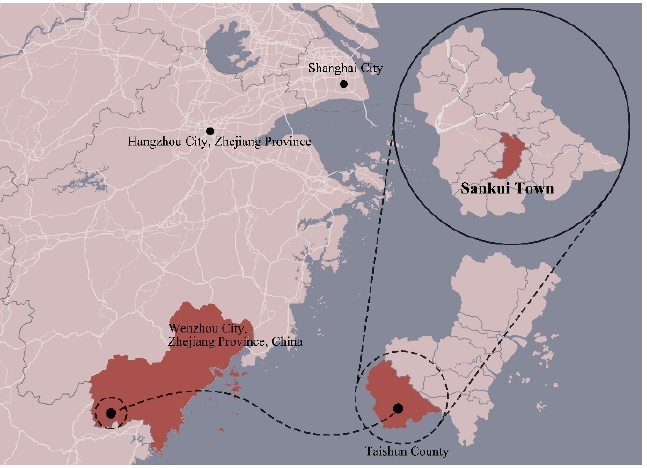
Figure 1. The position of Sankui Town, where the Taishun Hundred-family Feast culture exists.